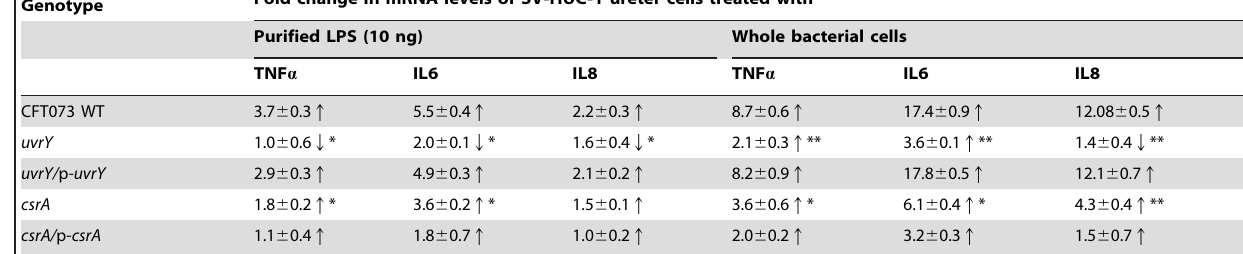
Genotype Fold change in mRNA levels of SV-HUC-1 ureter cells treated with Purified LPS (10 ng) Whole bacterial